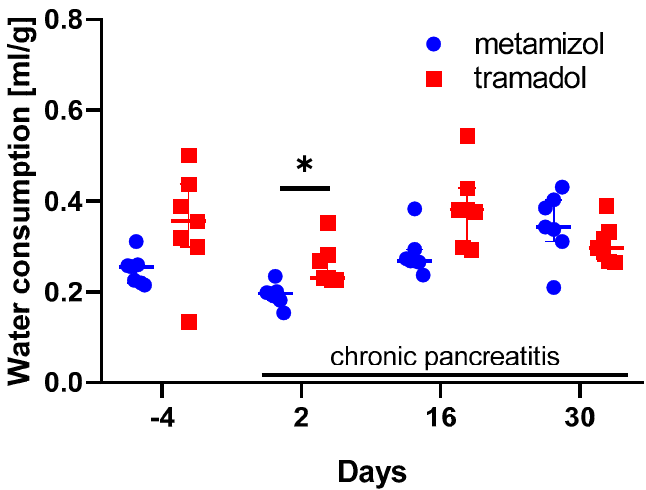
Figure 6. Impact of analgesics on water consumption during chronic pancreatitis. Water consumption (mL) divided by body weight (g) was assessed before (day − 4) and during the early (day 2), middle (day 16), and late phase (day 30) of chronic pancreatitis. * p ≤ 0.05 between the metamizole and tramadol group was obtained (two-way repeated measure ANOVA with Sidak’s correction for multiple comparisons). Metamizole: n = 7; tramadol: n = 7.